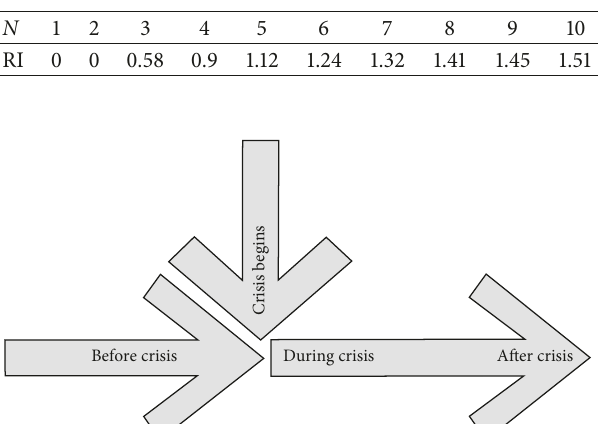
Figure 2: A decision hierarchy illustration. Table 1: Determination of the random index.